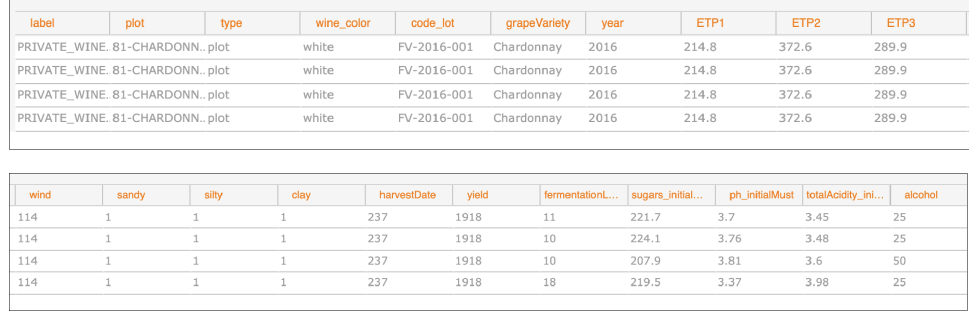
Figure 7. The data table from Figure 4d showing the same data as the parallel